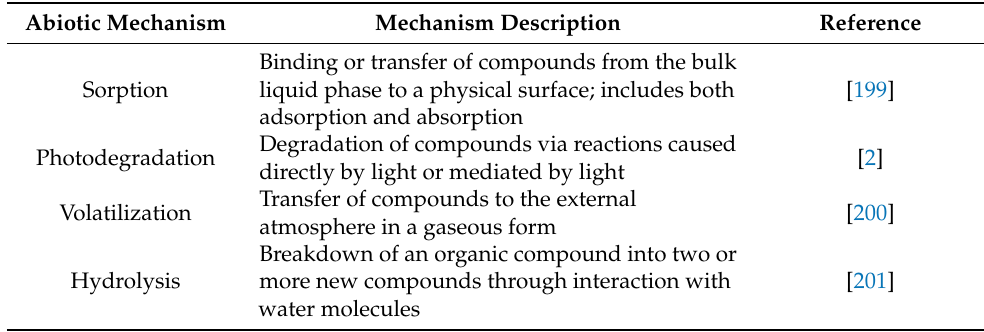
Table 3. Abiotic emerging contaminant removal mechanisms in wetlands.